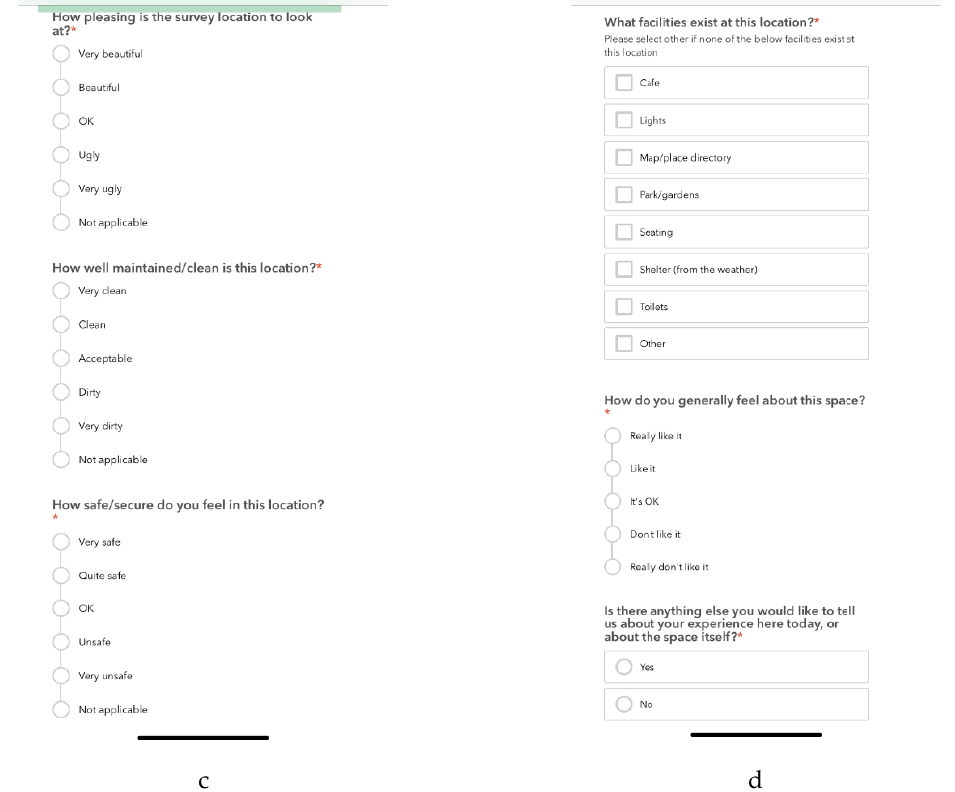
Figure 1. Outdoor Space Audit Tool (screen capture from a smart phone): ( a ) shows the opening screen of the audit tool; ( b ) shows the location data and photograph questions; ( c ) and ( d ) show examples of the questions from the audit tool.